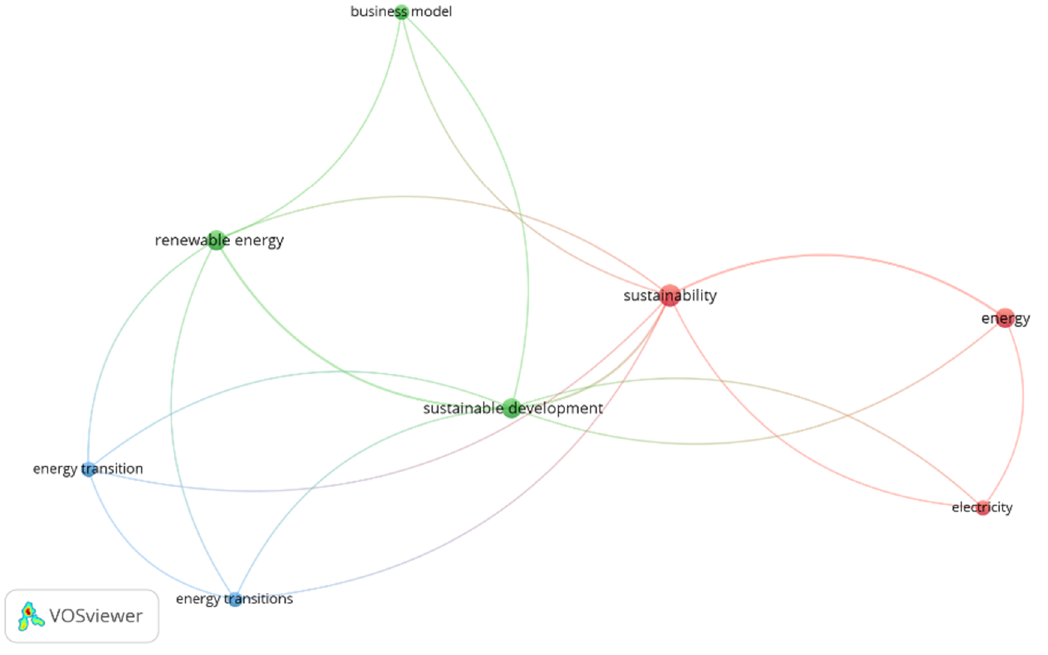
Figure 8. Bibliometric map of index keyword co-occurrences from Scopus based on Query 20’s re-